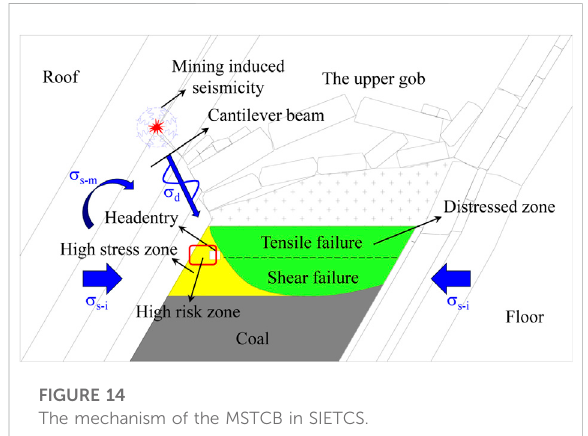
FIGURE 14 The mechanism of the MSTCB in SIETCS.